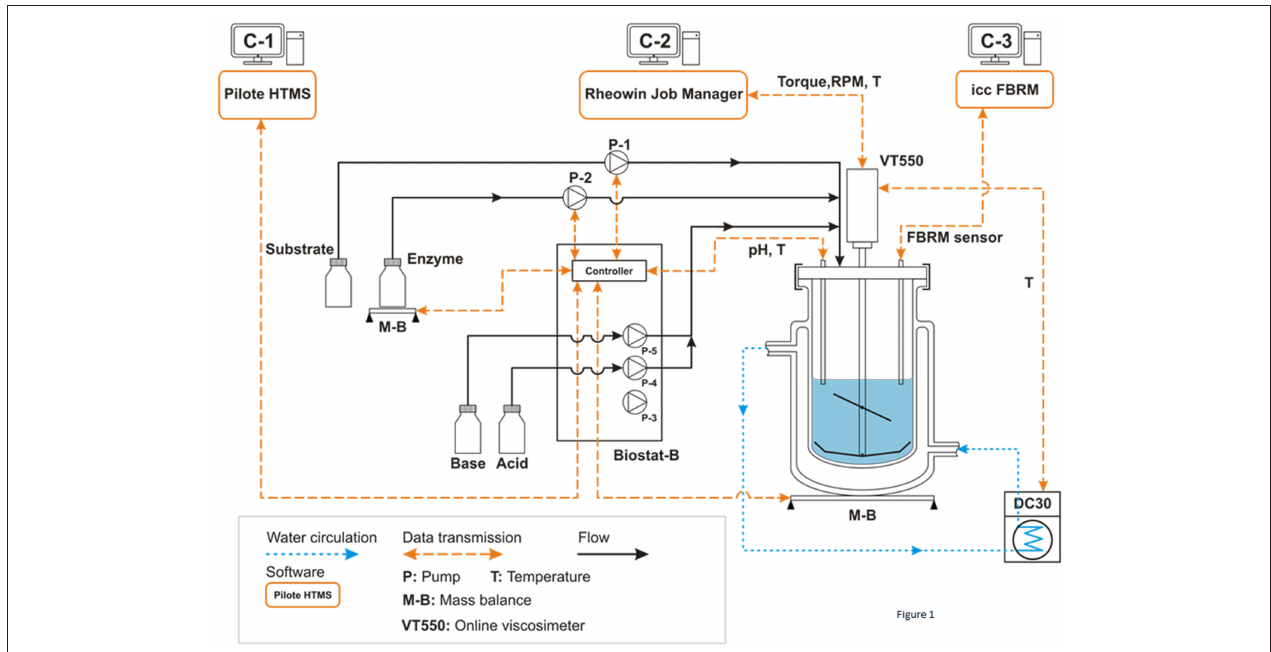
FIGURE 1 | Process and instrumentation diagram of the experimental setup. All experiments were conducted in batch mode. Pump P1 (archimede screw pump) is used to load progressively the reactor with the wheat bran substrate in order to generate a homogeneous suspension under permanent mixing. Pump P2 (volumetric peristaltic pump) is used to add quickly the enzymatic cocktail at a defined time (From Le et al.,